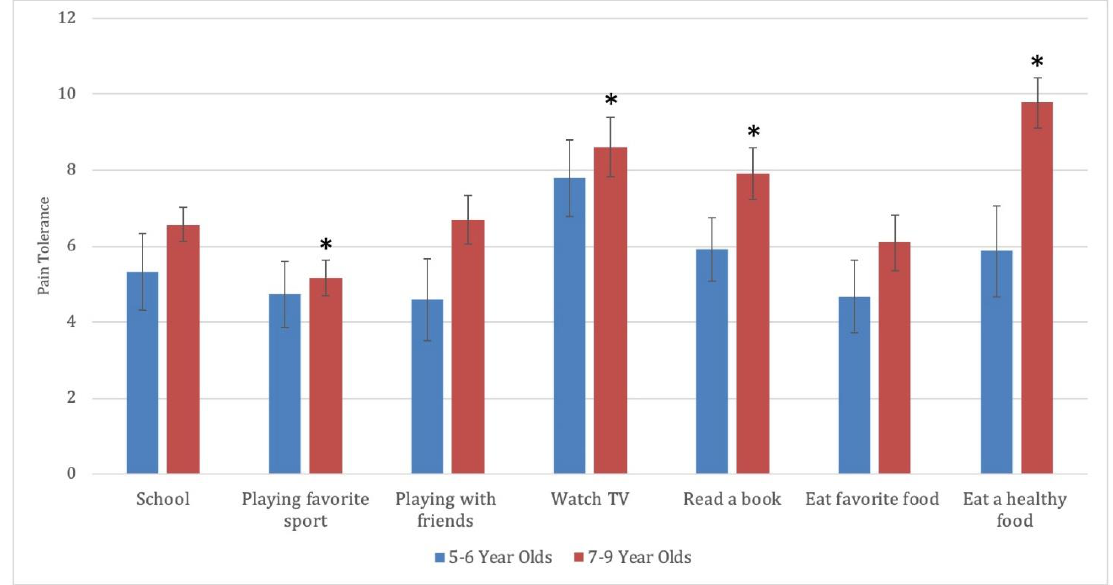
Figure 2. Toleration of Pain in Diverse Situations. Note. Children were asked how much pain Teddy could have and still engage in various categories of activities. Children indicated these pain thresholds on a pain thermometer numbered from 0 to 12 with higher numbers (as also indicated by verbal descriptions and colors) as indicating greater pain. All categories were compared to the level the children indicated Teddy could tolerate and still attend school. Error bars represent the standard errors of the mean. * = significance level is p < 0.05.